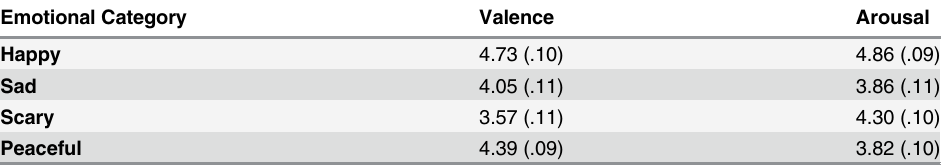
Table 1. Average valence and arousal ratings of musical excerpts. The table lists the average valence and arousal ratings for the four different types of musical excerpts (happy, sad, scary and peaceful) used as primes. (SE of the mean).